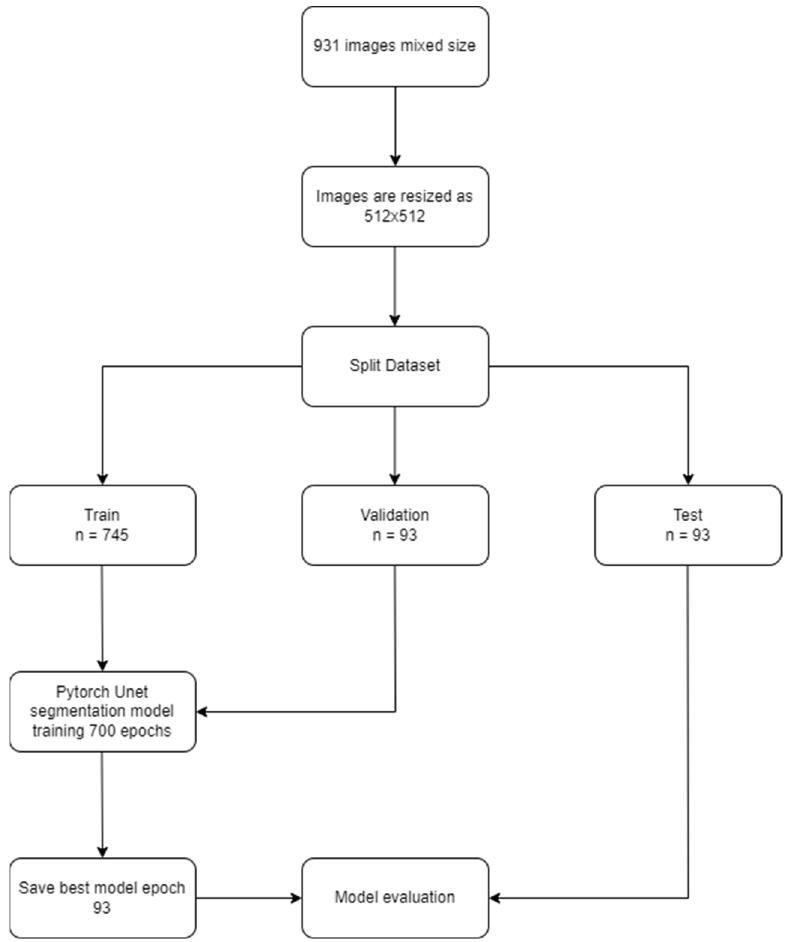
Figure 1. Model pipeline of parotid gland segmentation.